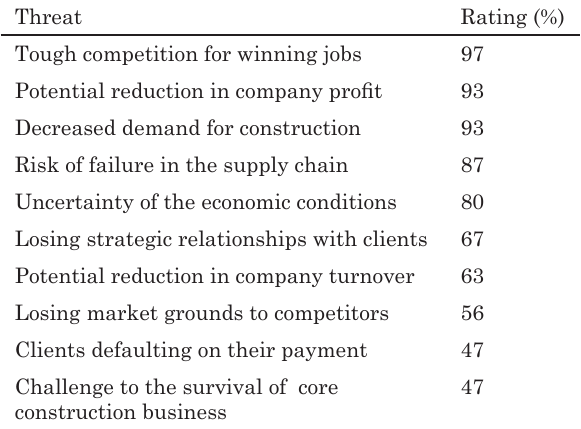
Table 4. Threats during the